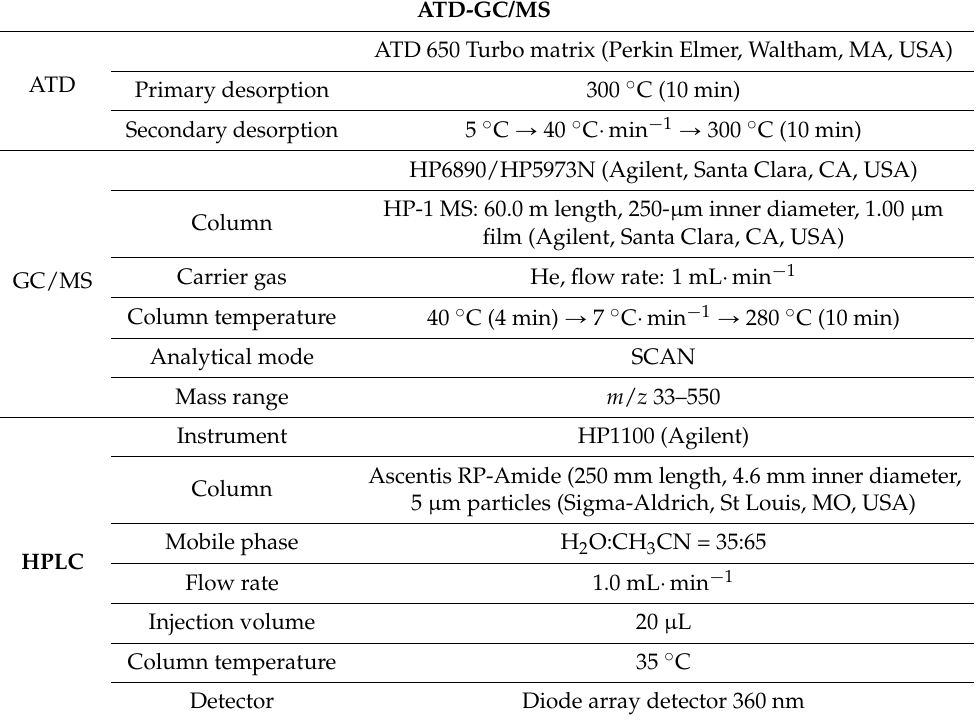
Table 2. Analytical conditions used for the automated thermal desorption-gas chromatography/mass spectrometry (ATD-GC/MS) and high-performance liquid chromatography (HPLC)